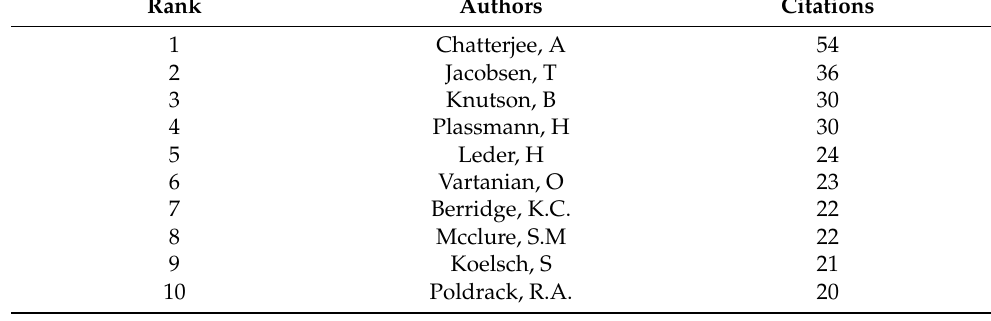
Table 9. Top 10 Most Local Cited Authors.